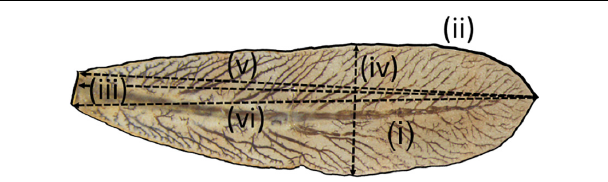
FIGURE 1 | Caudal lamella of a Coenagrion larva. Marked are distances measured for each lamella. Distances measured were (i): lamella area, (ii): perimeter of caudal lamella, (iii): length of major axis, (iv): the largest width perpendicular to the major axis, (v): the distance between the upper end of the lamella base and the lamella tip, and (vi): the distance between the lower end of the lamella base and the lamella tip. Measurements were taken using “ImageJ” [NIH; Abràmoff et al. (2004)]. All measurements were made in mm or mm 2